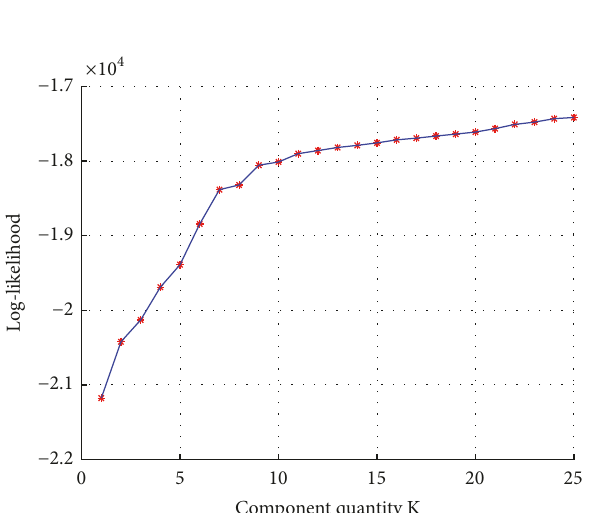
Figure 6: Cross-validation results.